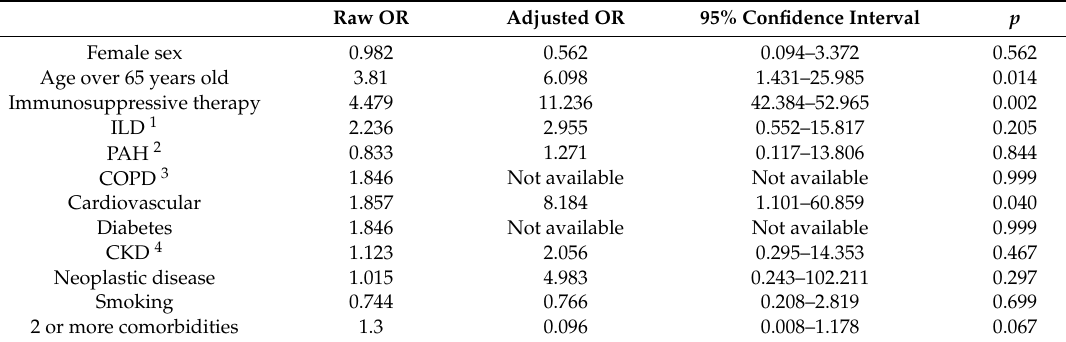
Table 5. Raw and adjusted odds ratios on each factor evaluated for S. pneumoniae vaccination. Raw OR Adjusted OR